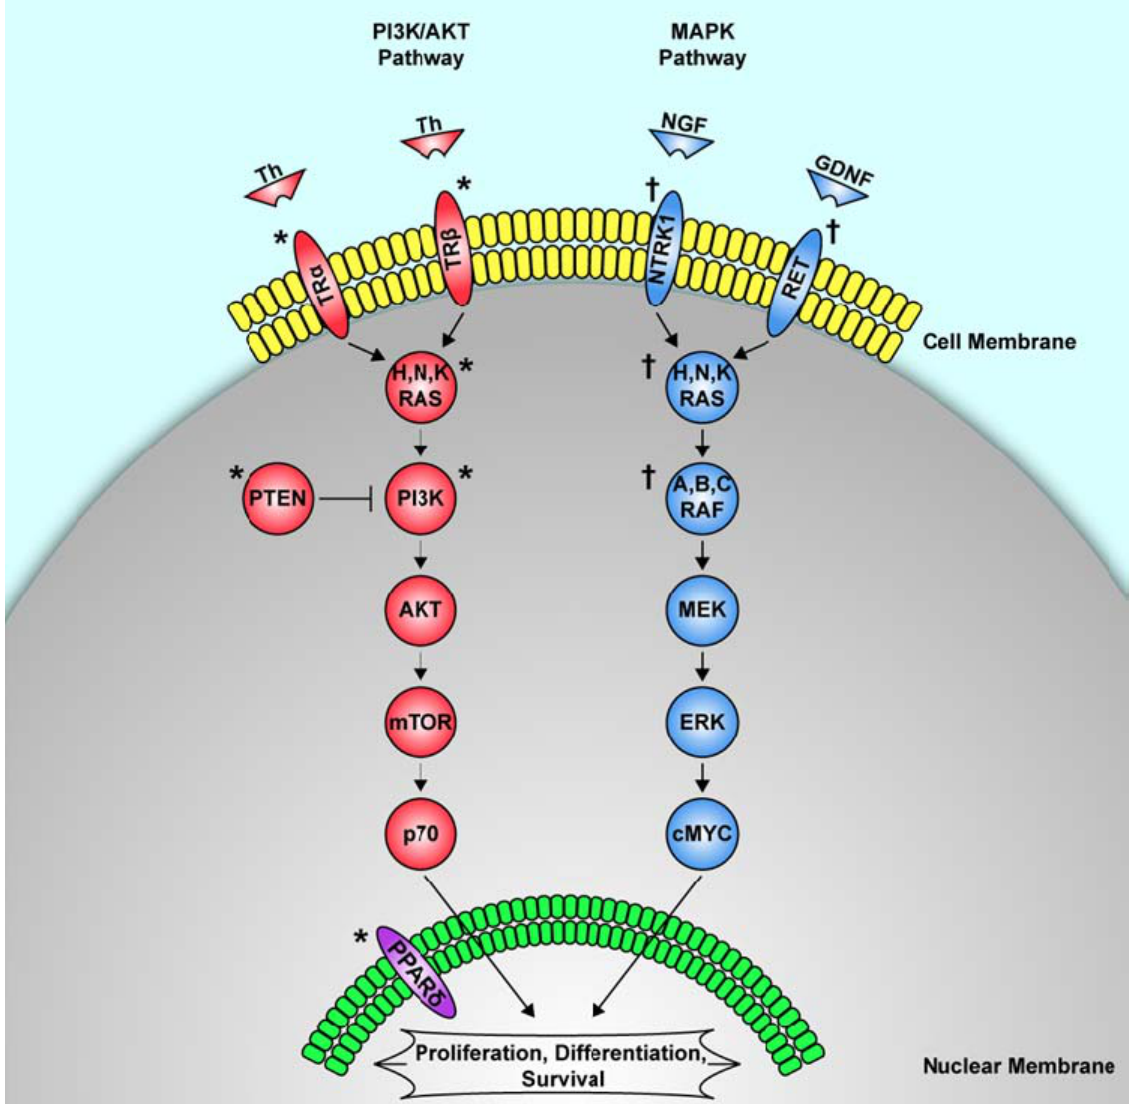
Figure 1. Genetic Mutation Pathways Associated with Sporadic Thyroid Cancer. Sporadic thyroid cancer is thought to occur via three independent cellular pathways based on the type of sporadic genetic mutation that leads to the development of thyroid cancer.